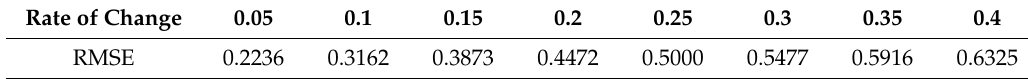
Table 5. RMSE calculation results of variations in head for Scenario Two.